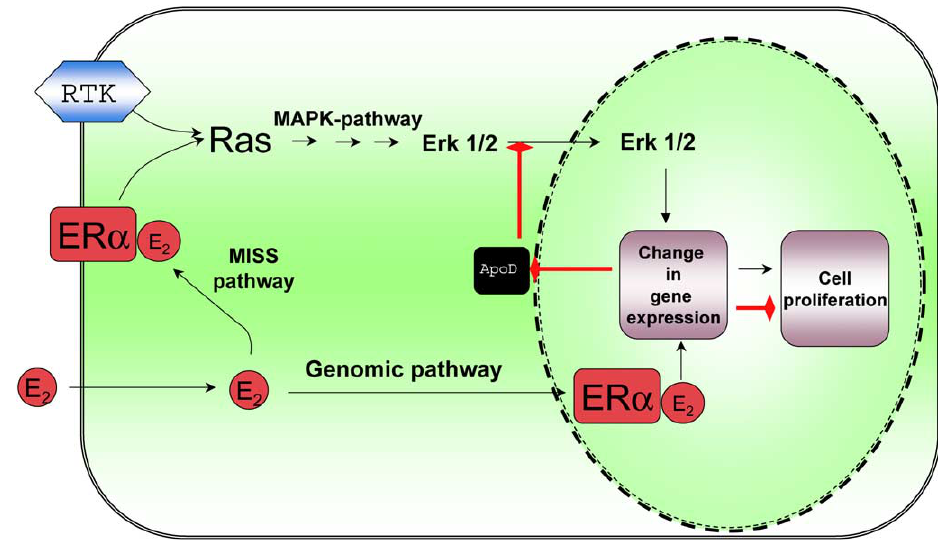
Fig. 4. ApoD and interaction in the MAPK and genomic –ER α and MISS–ER α pathways. In the MAPK pathway, ApoD is shown to inhibit ( ) the translocation of Erk 1/2 (= MAPK) from the cytoplasm into the nucleus. Hence, transcription of factors that increase proliferation is inhibited. ER α stimulates proliferation ( ), but inhibits ( ) ApoD transcription. This inhibition of ApoD is “a gate opener” for the MISS-ER α pathway which acts through the Ras/MAPK pathway; consequently cell proliferation is enhanced. Abbreviations: ApoD: apolipoprotein D; ER α : oestrogen receptor α ; E 2 : oestradiol; Erk 1/2: extracellular regulating kinase; MAPK: mitogen activated protein kinase; MISS: membrane initiated steroid signalling; Ras: rat sarcoma virus oncogene; RTK: receptor tyrosine